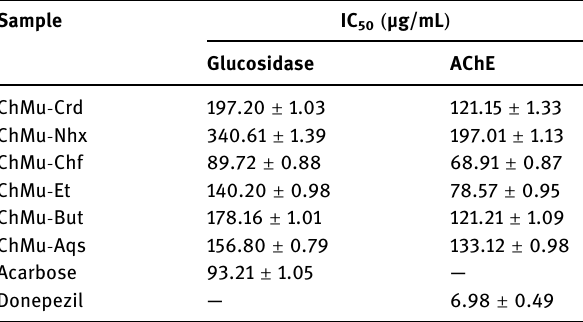
Table 6: Enzyme inhibition of crude extract and fractions against IC 50